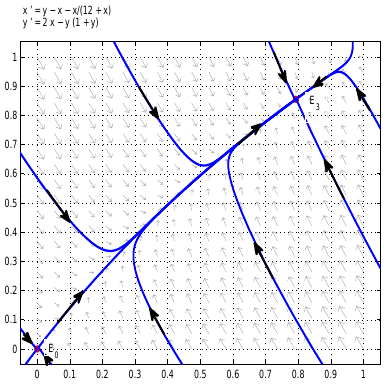
Figure 4. A unique internal equilibrium E 3 is globally asymptotically stable when b < c ( e − a ) and ∆ ( b ) >